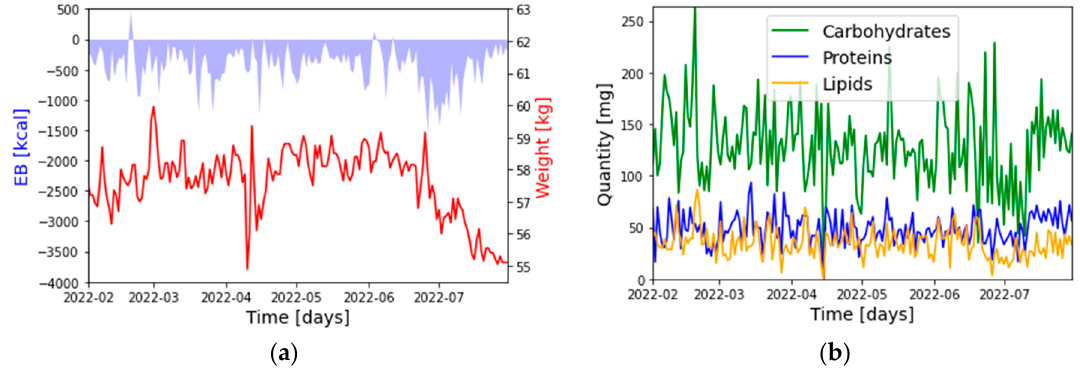
Figure 1. Weight, EB ( a ) and food composition ( b ) time series (for user 2).